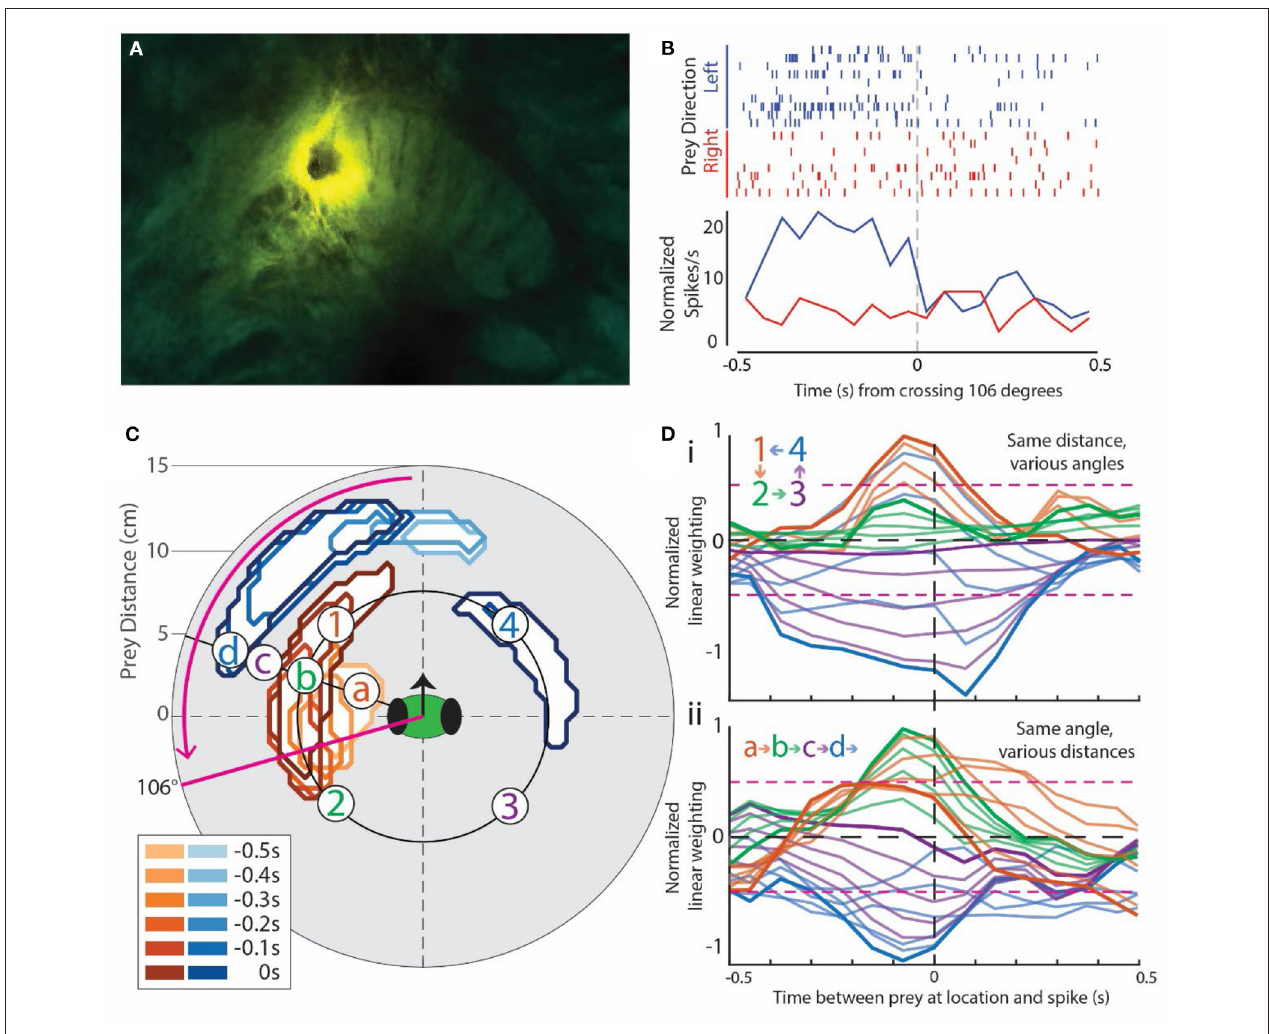
FIGURE 2 | Example of prey-motion-responsive cell. All data in this Figure are from the same cell located in the left fan-shaped body (FB). It was chosen because it exemplified the most common subtype of prey-responsive cells and direction selectivity, and it had clear positive and negative correlation regions in the visual field. (A) Image of the central complex showing the lesion dye from the electrode on the mantis’s right-side FB. (B) Rasters (top) and peri-stimulus time histogram (PSTH, bottom) for the angle at which prey movement elicited the greatest response in this cell, which, in this case, was back and forth around 106 ◦ to the left of the mantis’s forward-facing visual field [refer to the solid magenta line in (C) ]. Trials are split into the left- (blue) and right-moving prey (red). The corresponding PSTHs were calculated as the sum * (spikes in bin for all trials)/(number of trials) * (length of the bin). This normalized each PSTH for unequal numbers of left and right trials (see Methods for more detailed explanation). (C) Contours outlining the positions of the moving prey with significant weights in the generalized linear model for this cell. Warm colors indicate regions with positive weights (analogous to positive correlation), and cool colors indicate negative weights. The inset box is a legend indicating the delay between prey in the area outlined by the contour (lighter colors for longer delays) and a spike in this cell. In effect, a prey stimulus in the outlined area is associated with a spike at some time delay later. The magenta arrow indicates the direction of prey movement that produced a larger response in the PSTH in (B) . (D) Spatial temporal receptive field (STRF) plots taken from various locations in the contour plot in (C) . A peak to the left of 0 that rises above the 2-SD level (dotted magenta horizontal lines) indicates a strong correlation with movement before an increase in spike activity. A peak that goes below the lower 2 SD line indicates a negative correlation between movement and activity (decrease in spiking). (D i ) includes samples from 4 numbered regions indicated in (C) around the same distance. The color of each curve matches that of the site indicated in (C) (labeled a–d). Darker curves are the correlations for prey at the indicated points, and the lighter curves are the correlations at equally spaced points between these points. Light brown lines are at points taken between the points labeled 1 and 2, light green lines from points between 2 and 3, and so on. This progression is indicated in the insert on the plots. (D ii ) shows lettered responses to sites at the same angle relative to the head of the mantis but at different distances. In this case, sites at which the curves are recorded are indicated as letters on the contour map in (C) and colors of the STRF curves match those of the letters in (C) .